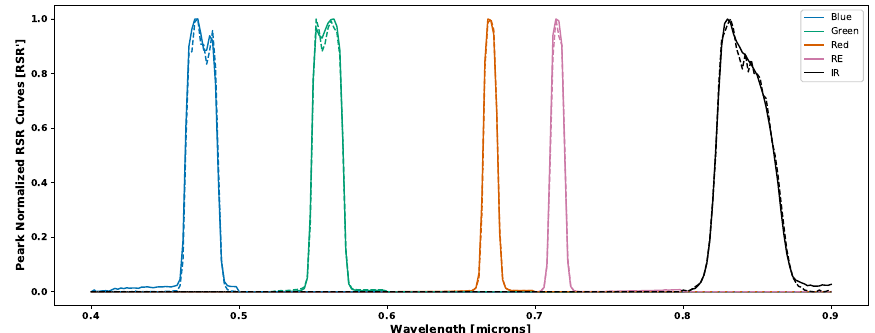
Figure 2. Peak normalized relative spectral response of RedEdge-3 (solid lines) and RedEdge-M (dashed lines) sensors. Small variations can be seen in all channels of both sensors. RedEdge-3 contains small divots in the blue and green channels, while the Red, RE and NIR channels have small but noticeable shifts between the two